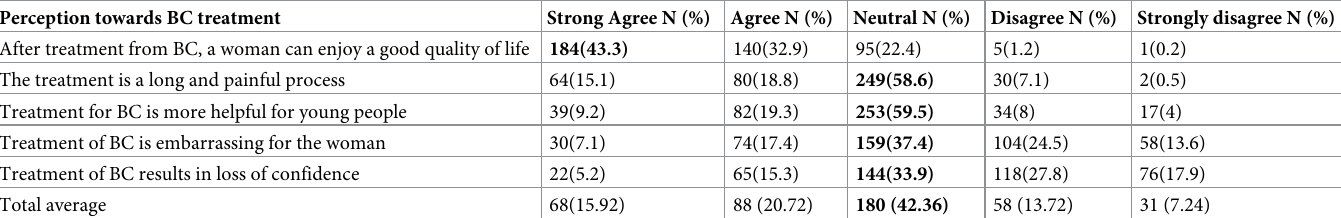
Table 5. Respondents’ perception towards breast cancer